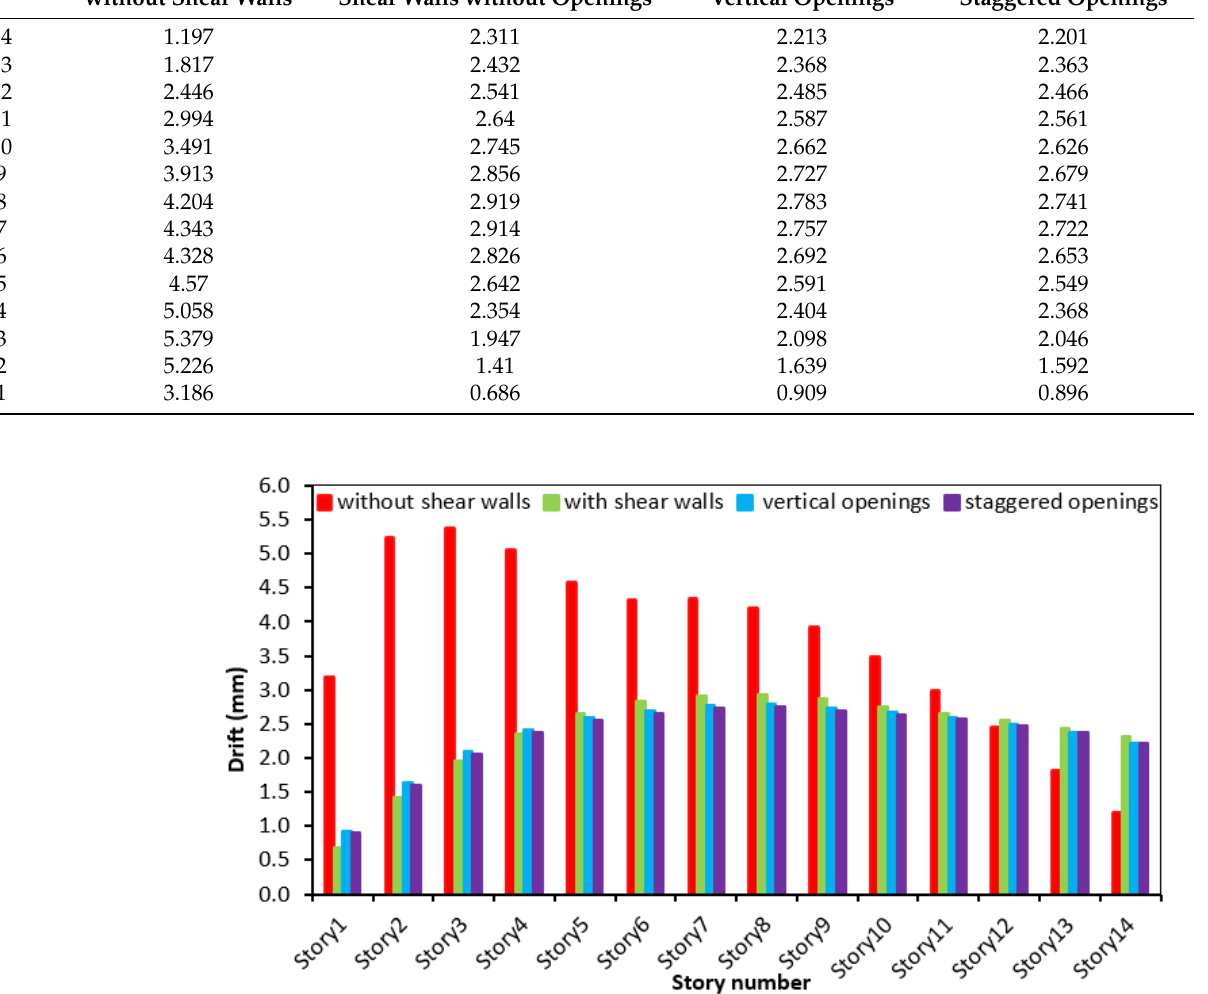
Figure 17. Story drift of the models, time history analysis, X-direction.